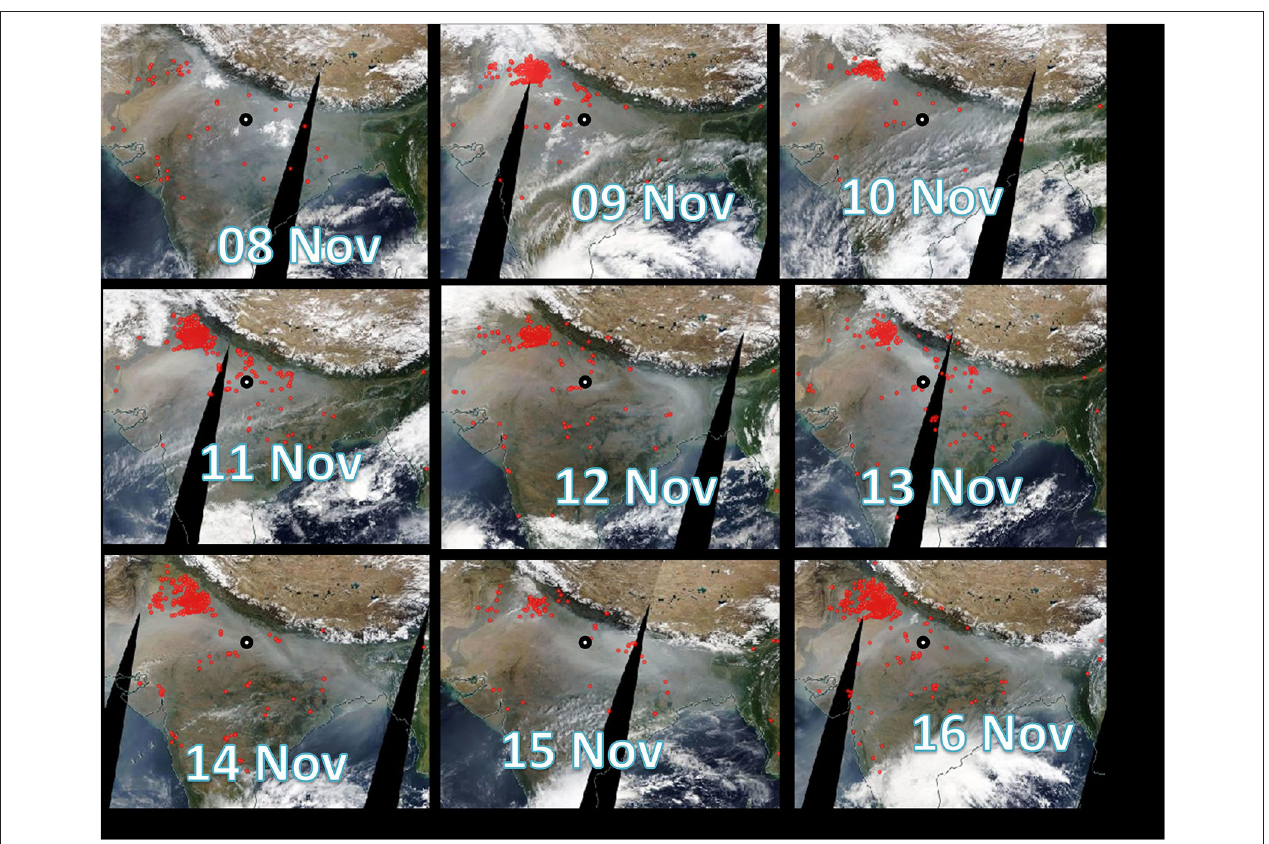
FIGURE 5 | Satellite imageries (Moderate Resolution Imaging Spectroradiometer sensor: MODIS, NASA on board Terra and Aqua satellite) showing fire count data over IGP during study period. The sampling site is shown by black